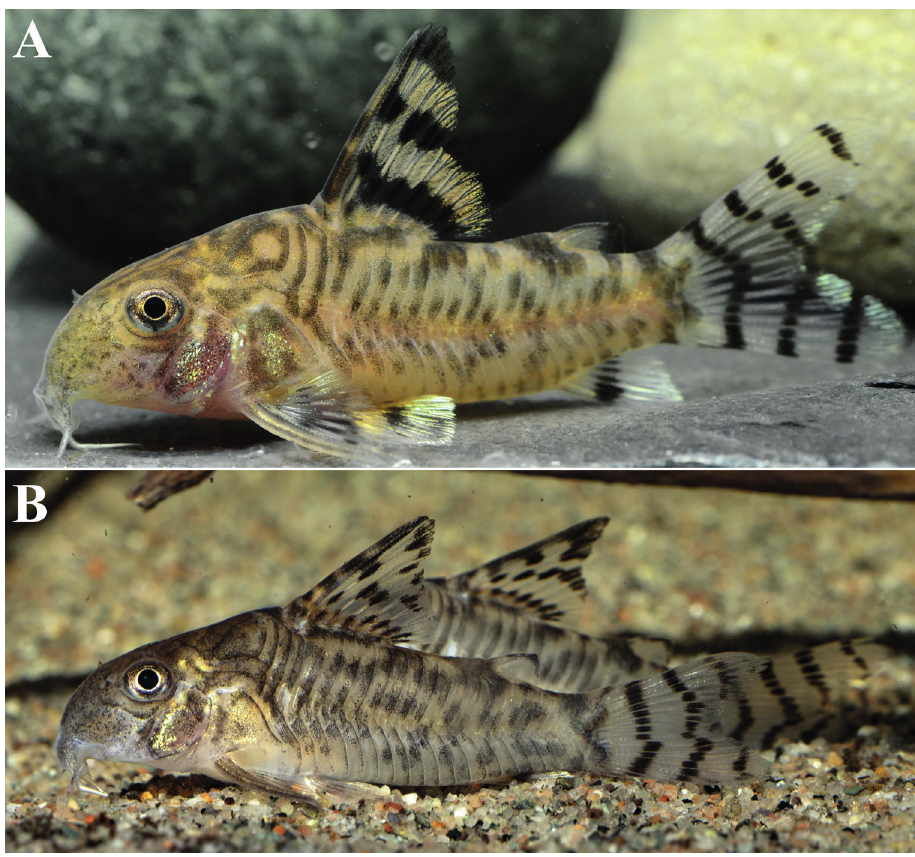
FIGURE 10 | Uncatalogued aquarium specimens of Corydoras hypnos photographed alive, showing general morphology and color pattern of ( A ) a specimen with brownish yellow ground color of body, and ( B ) and two specimens with greyish yellow ground color of body. Photos by Robert McLure ( A ) and Oliver Lucanus ( B